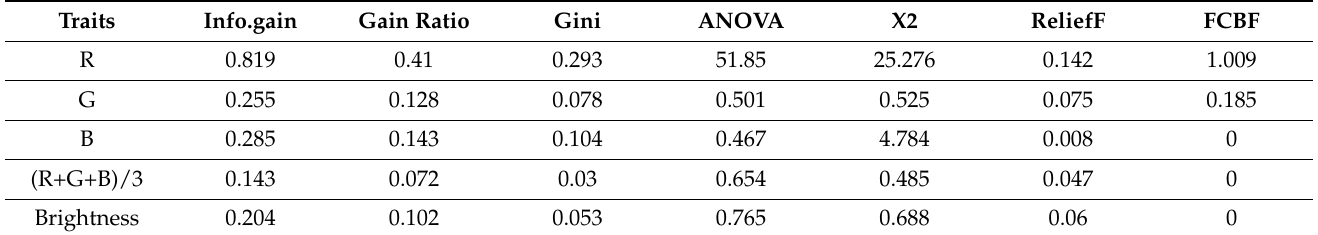
Table 1. The classification percentage for RGB